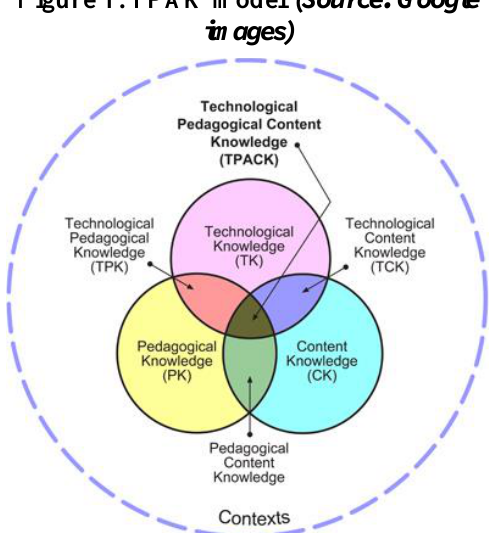
Figure 1. TPAK model (Source: Google